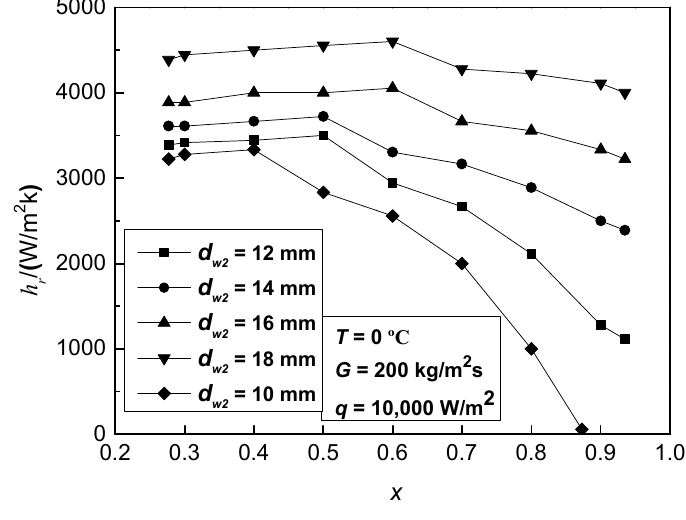
Figure 13. Effect of d w2 on h r. Figure 13. E ff ect of d